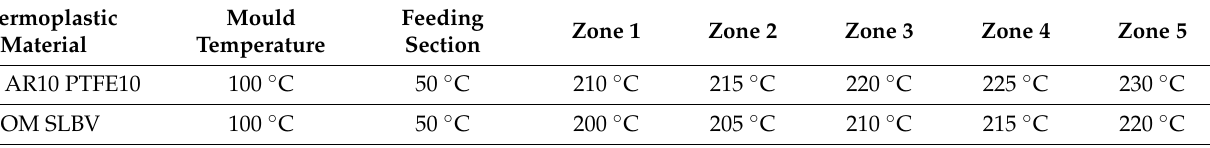
Figure 2. Titanium insert placed within the aluminium mould; the insert was built at an angle of 90°. Table 3. Parameters used for overmoulding